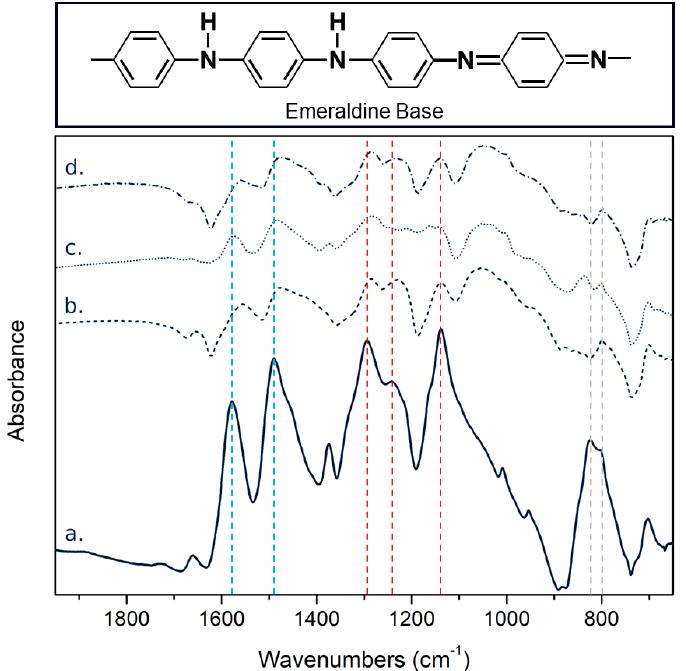
Figure 4. Chemical structure of the Pani’s emeraldine base and FTIR spectra of ( a ) PAni, ( b ) PAni- SnCl 2 , ( c ) PAni-PEDOT:PSS (3 wt%) and ( d ) PAni-SnCl 2 -PEDOT:PSS (3 wt%). The blue, red and grey lines correspond to the bands relative to the oxidation process, the protonation and the substitution of the aromatic rings, respectively.